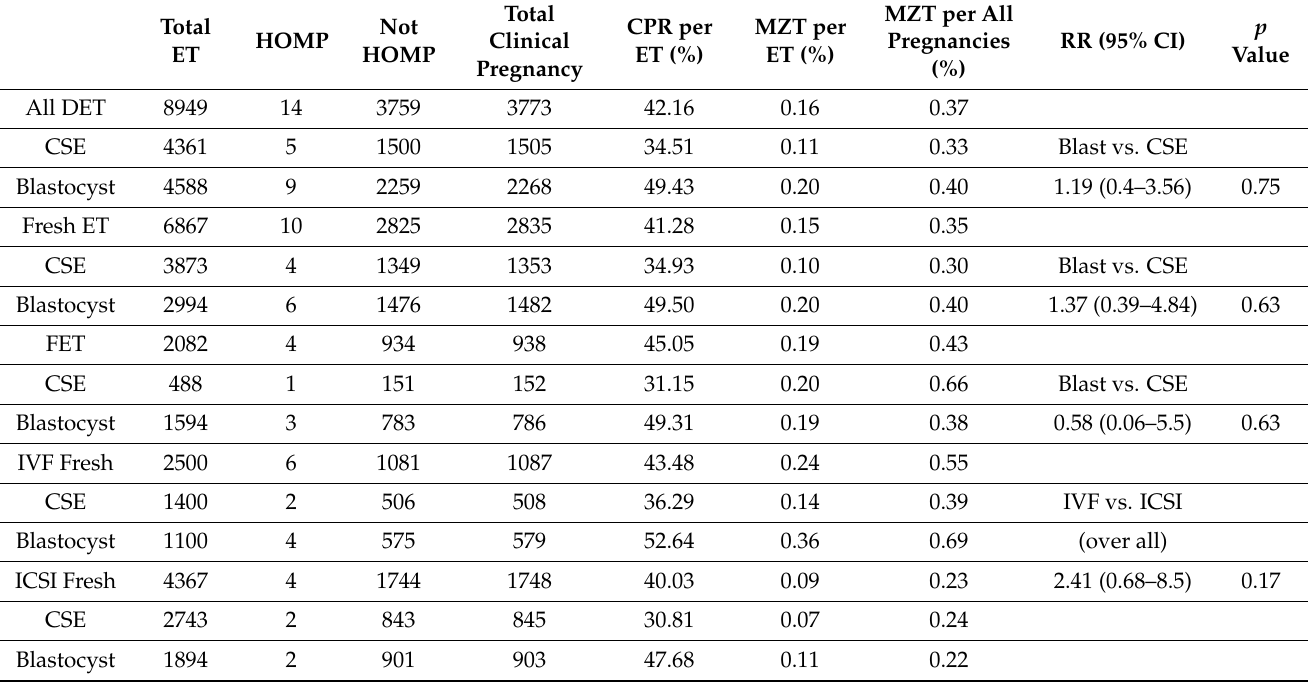
Table 2. DET cycles and MZT